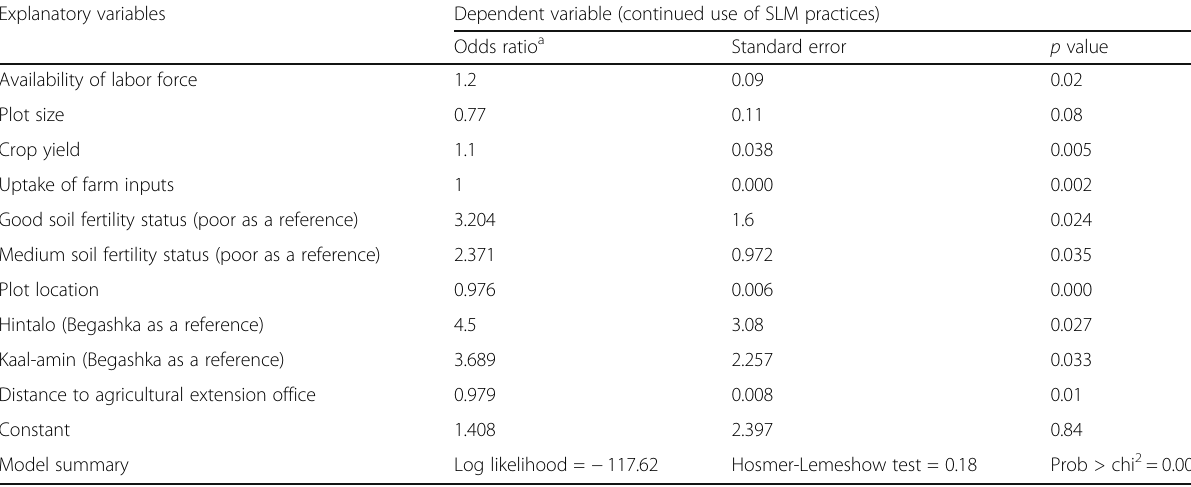
Table 6 Binary logit results on determinants for the continued use of SLM practices Explanatory variables